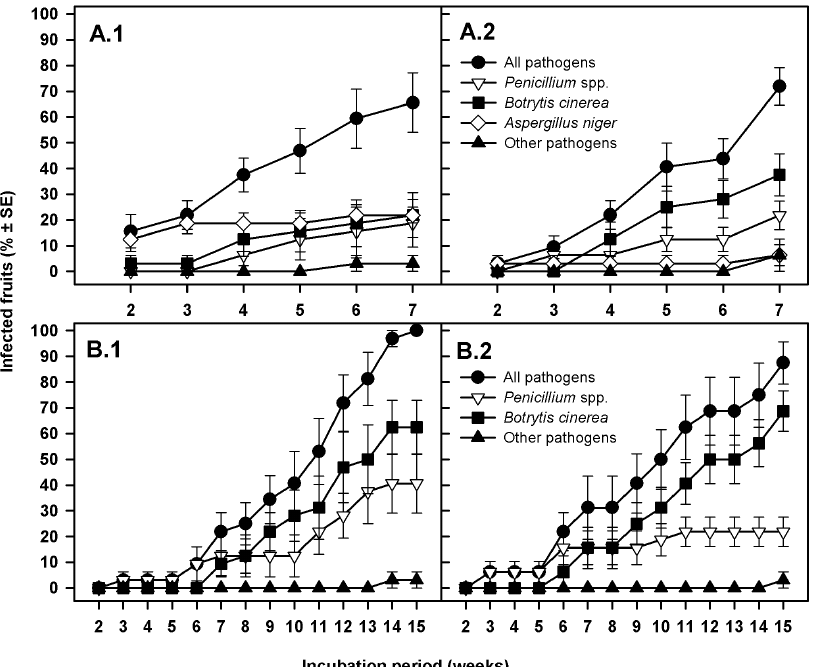
Figure 1. Incidence of postharvest diseases caused by latent pathogens on pomegranates cv. Mollar de Elche from two orchards (1 and 2) surface-disinfected and incubated at 20ºC for 7 or 15 weeks. Data from two consecutive seasons, 2005 and 2006 (A and